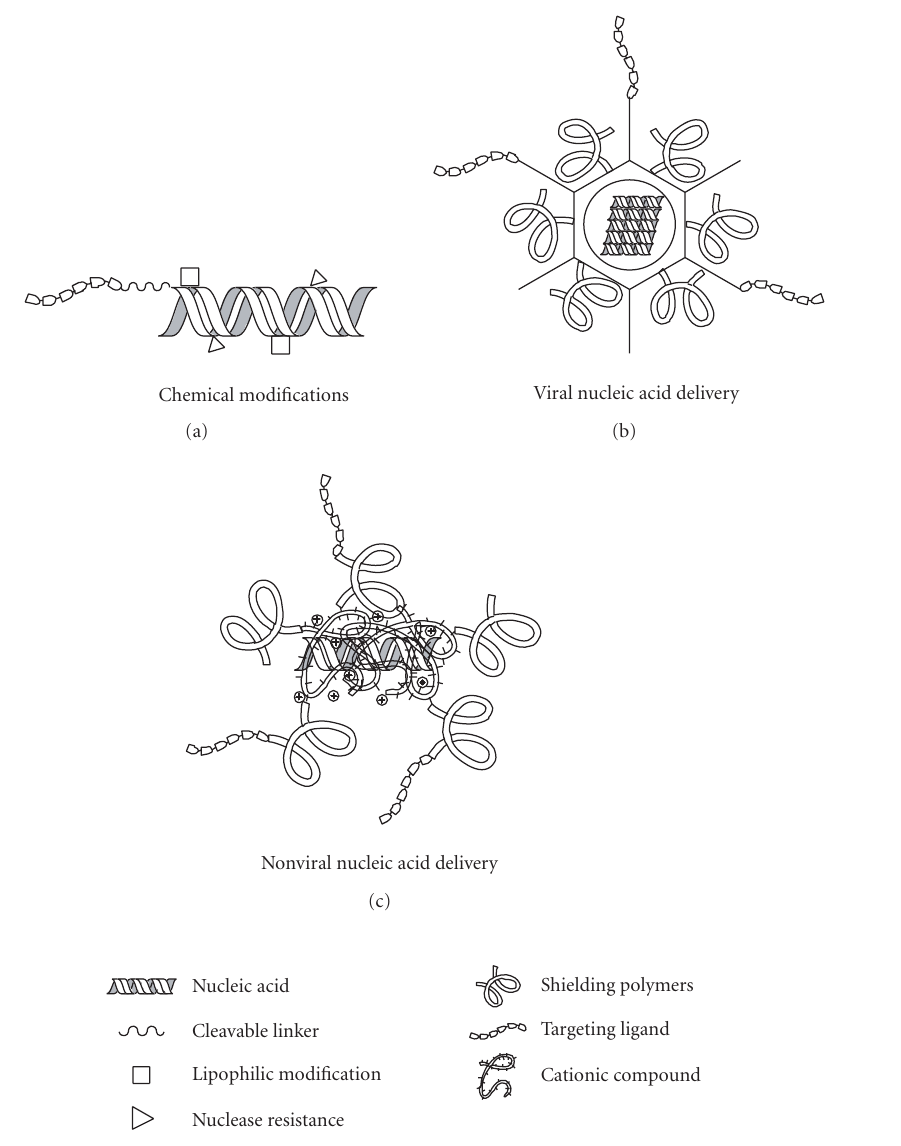
Figure 2: Strategies for siRNA delivery. Strategies are based on (a) chemical modifications of siRNA, (b) targeting of siRNA using viral vectors, or (c) nonviral delivery